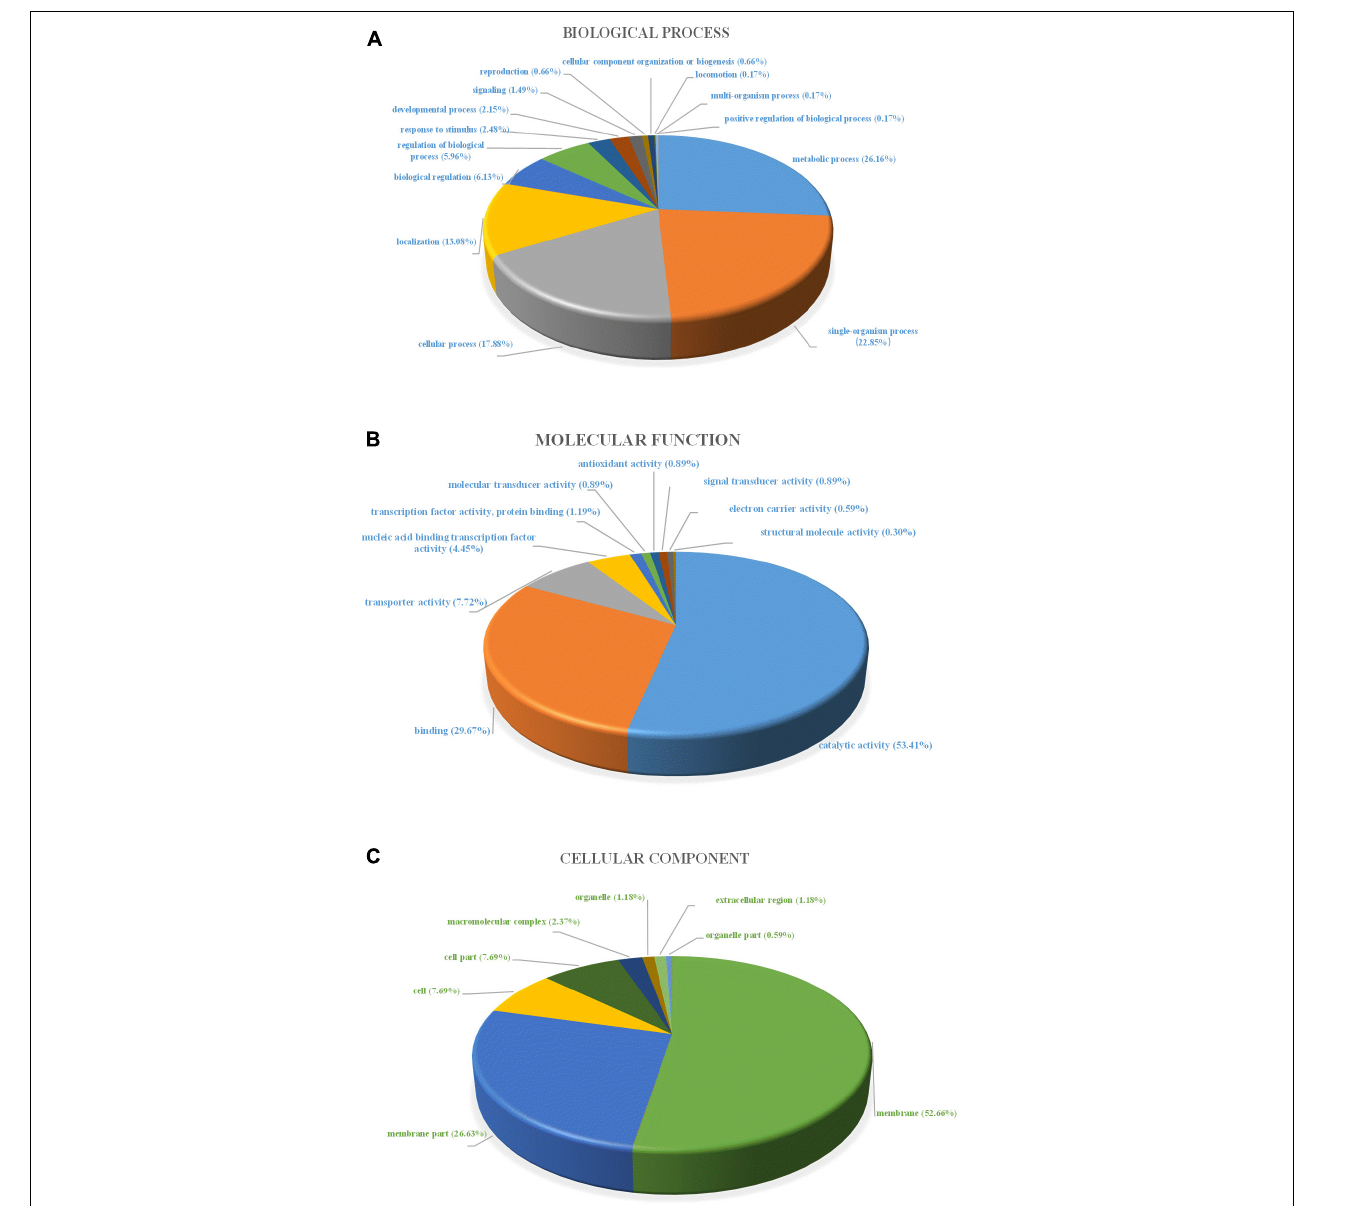
FIGURE 4 | Gene ontology (GO) functional analysis of unique sequences from control group and alkali stress group transcriptome. Unique sequences were assigned to three categories: (A) Biological process, (B) Molecular function, (C) Cellular